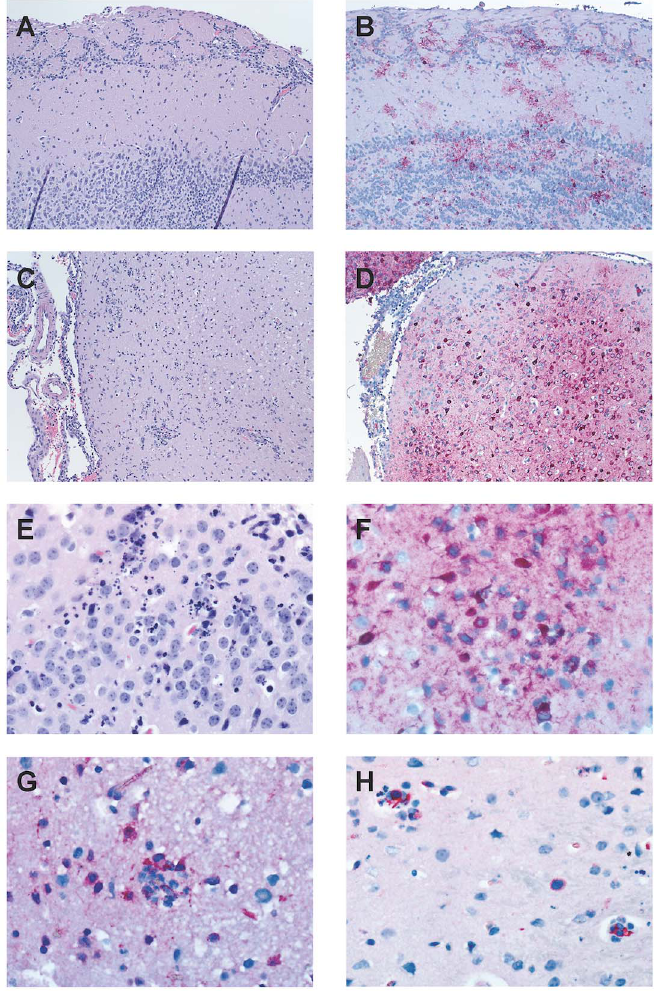
Figure 9. Infection of D NSs virus IN causes meningoencephalitis with inflammatory foci characterized by apoptosis and presence of viral antigen, T cells and microglia. Tissues were processed, paraffin-embedded, and sectioned following routine methods, and stained with hematoxylin and eosin (H&E) for histological examination. Immunohistochemistry (IHC) was performed using a monoclonal Rift Valley fever virus antibody to visualize viral antigen and with anti-CD3, anti-CD8, anti-CD20 and anti-CD68 antibodies to identify inflammatory cells. Viral entry appeared to be through the olfactory bulb: (A) H&E and (B) RVFV specific IHC. Meningoencephalitis with multifocal antigen staining is suggestive of subsequent hematogenous spread: (C) subcortical area, H&E and (D) same area, RVFV specific IHC. Inflammatory foci were characterized by (E) morphologic appearance of apoptosis and the presence of (F) RVFV antigen, (G) CD68 + microglia, and (H) CD3 + cells.